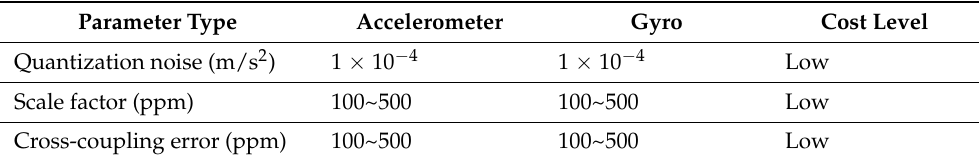
Table 2. IMU main